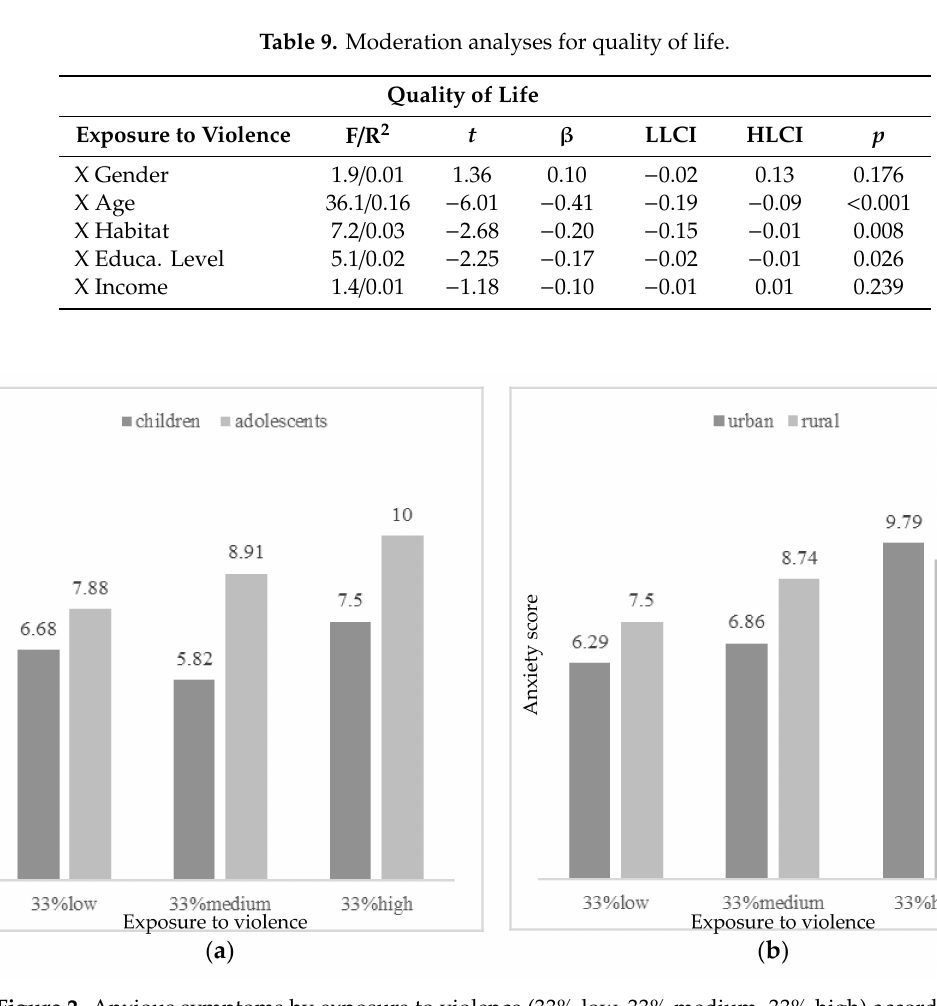
Figure 2. Anxious symptoms by exposure to violence (33% low, 33% medium, 33% high) according to ( a ) age (children vs. adolescents); and ( b ) habitat (urban vs.